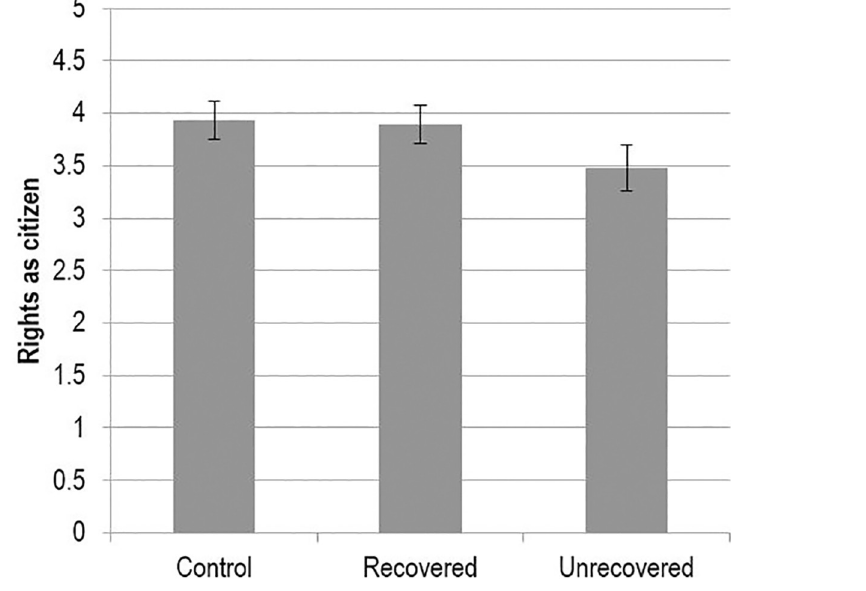
Fig 4. Means scores for rights as citizen measure (+/- 2